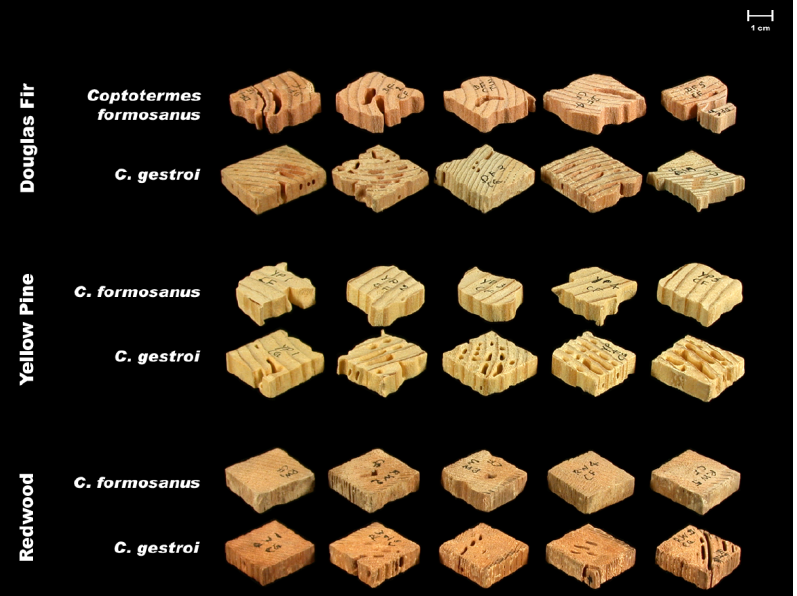
Figure 4. Extent of feeding by the two termite species on three wood